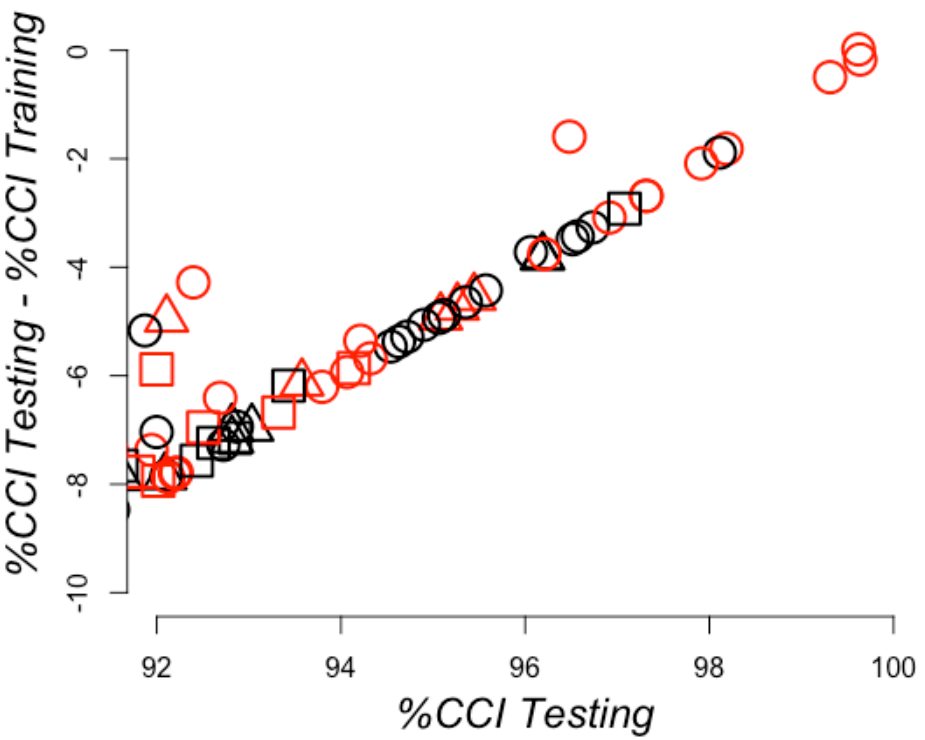
Figure 8. Learning efficiency on sampling training sets with redundancy. The percentages of correctly classified instances (CCI) for the testing sets ( X -axis) are plotted against the differences observed in these values for the testing and training ( Y -axes) sets. CCI corresponds to true predictions, including both positive and negative PPI. Therefore, 100% on the X -axes corresponds to not failing any prediction on the testing set and a 0 value on the Y -axis corresponds to no difference observed in the prediction between the training and the testing set. The best models are shown in the top right corner. Predictions achieved with raw RCCs are presented as circles, standardized RCCs as squares, and normalized RCCs as triangles. RCCs built using sidechains are otherwise shown in red and black.